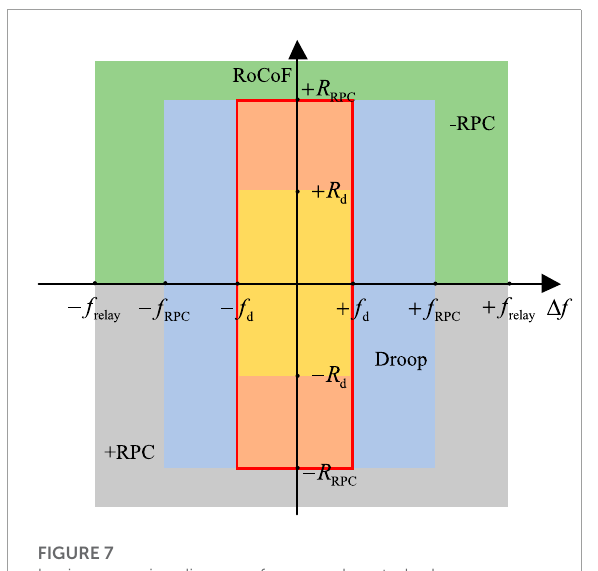
FIGURE 7 Logic conversion diagram of proposed control scheme.